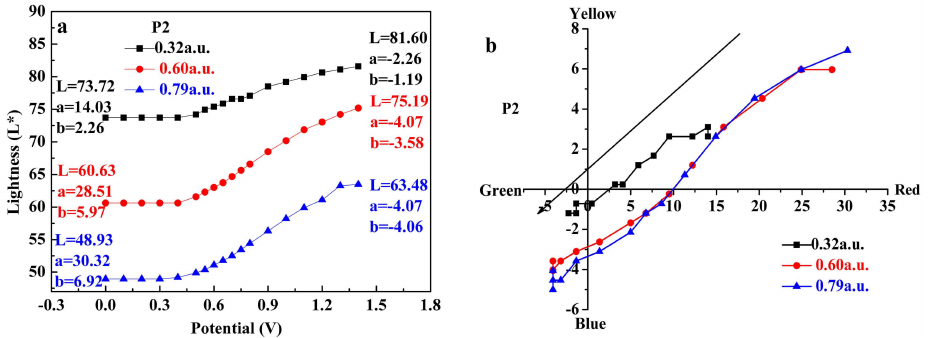
Figure 8. L * and a *, b * curves of P2 at different applied